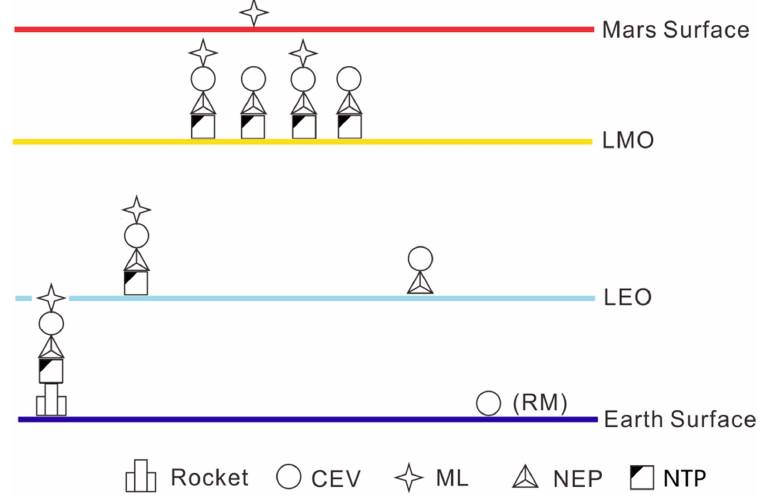
Figure 14. Schematic of Architecture-9. Table 17. Mission architecture matrix of Architecture-9.